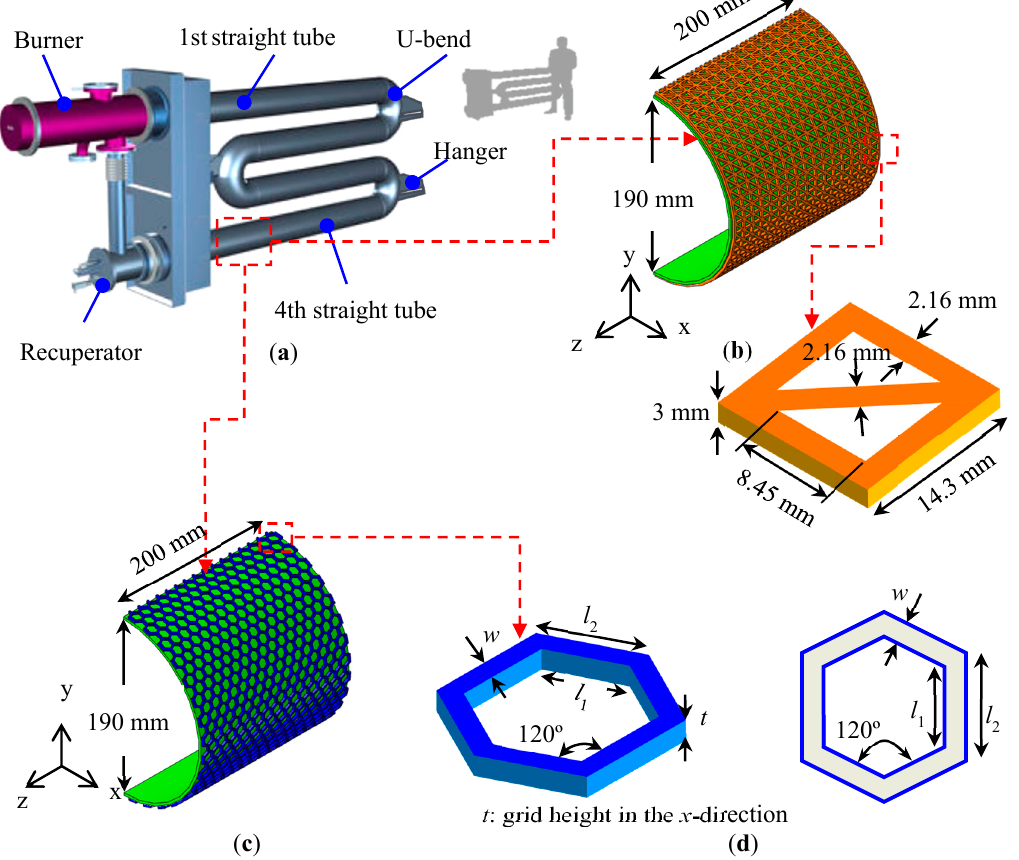
Figure 1. ( a ) Appearance and size of an actual radiant tube (RT). ( b ) A set of pratt truss patterns generated on a part of straight tube surface. ( c ) A set of honeycomb patterns generated on a part of straight tube surface. ( d ) Schematic of a honeycomb and design variables. ‘ w ’ represents the width of honeycomb grid. l 1 and l 2 stands for the inner and outer length of the honeycomb.